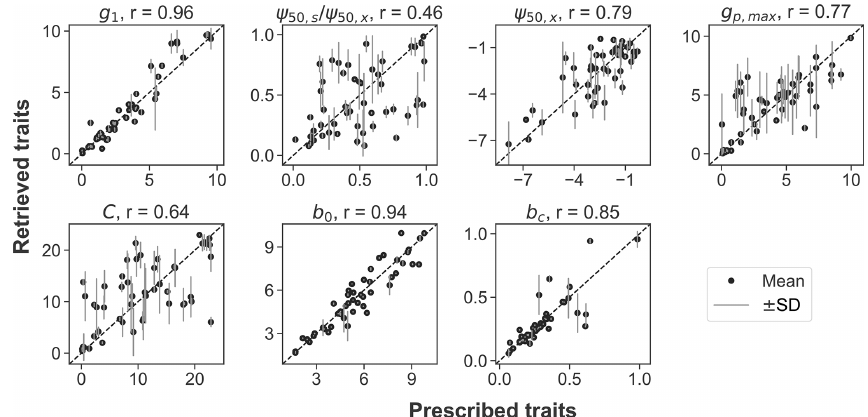
Figure 1. Comparison between the prescribed and retrieved plant hydraulic traits ( g 1 , ψ 50 , s /ψ 50 , x , ψ 50 , x , g p , max , and C ) and soil properties ( b 0 and b c ) in the observing system simulation experiment. The black dots and gray lines represent the mean and range of 1 standard deviation of the retrieved posterior distributions. The diagonal dashed line is the 1 : 1 line. Pearson correlation coefficient ( r ) between the prescribed and retrieved parameters is